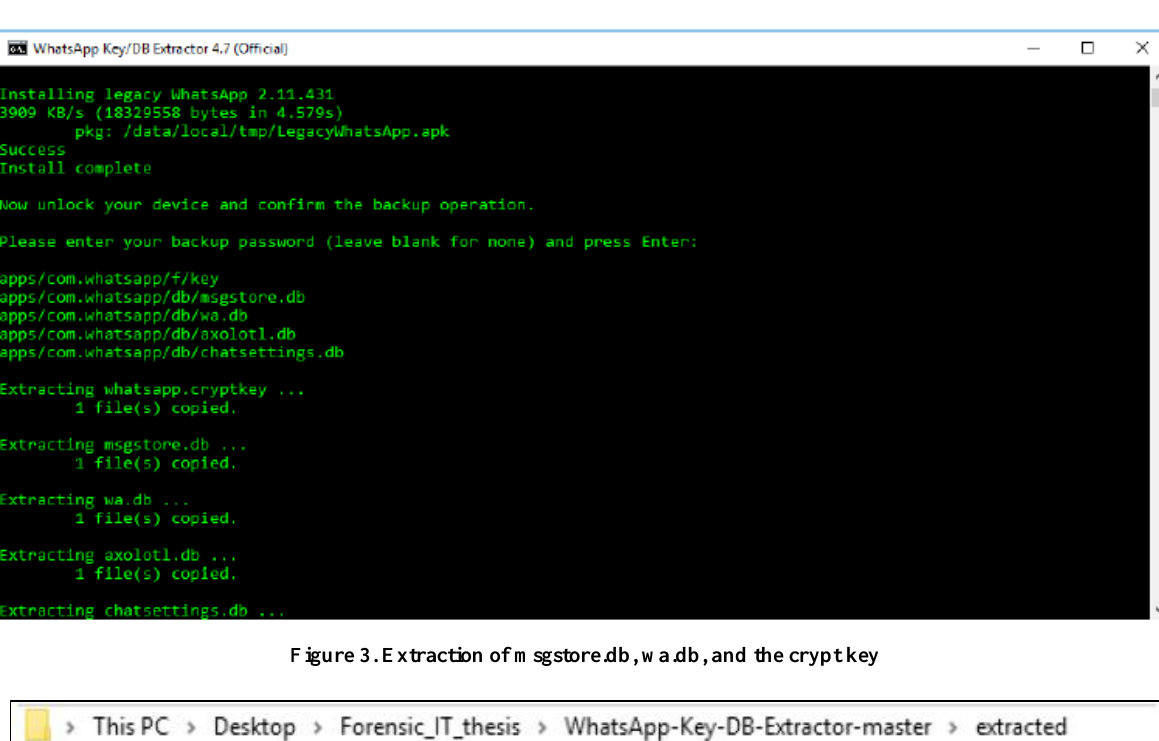
Figure 2. WhatsApp key/DB extractor - Downgrade and Backup WhatsApp